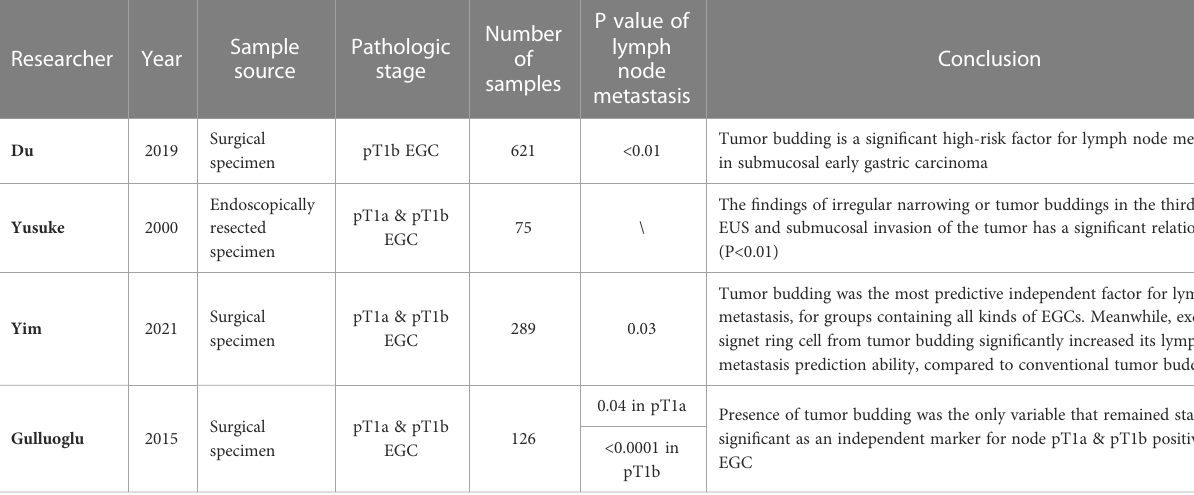
TABLE 1 Results of tumor budding in early gastric cancer.